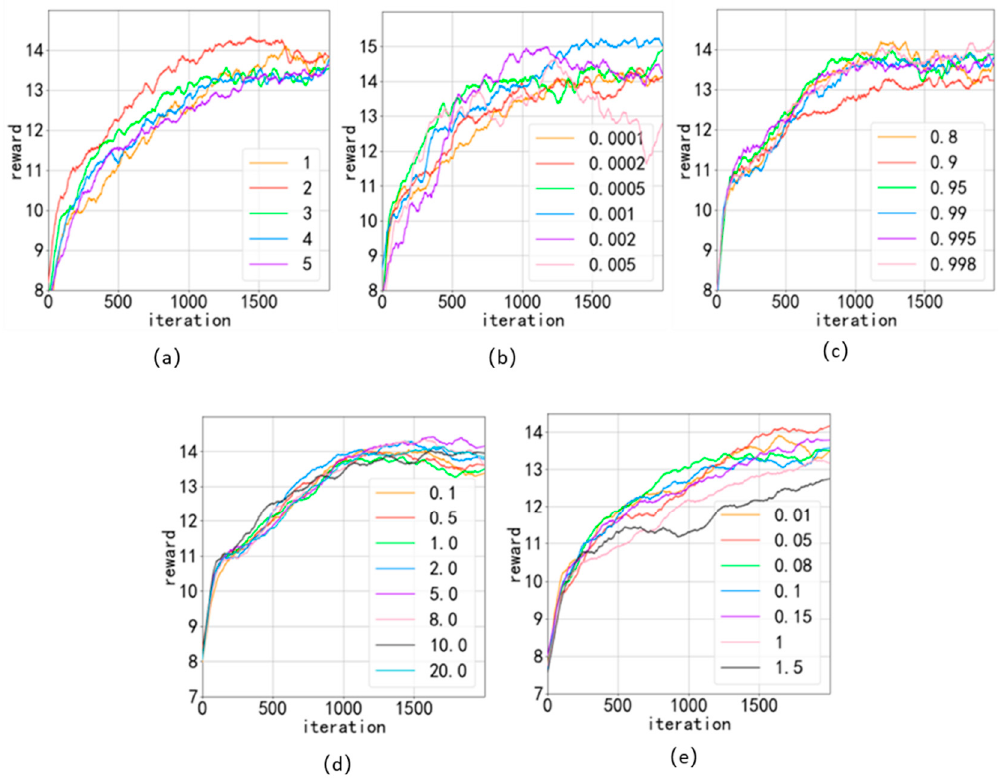
Figure 5. Comparison of the effect of some super-references: ( a ) ensemble number; ( b ) learning rate; ( c) ϵ -decay; ( d ) UCB exploration reward λ ; ( e ) weight parameter W .